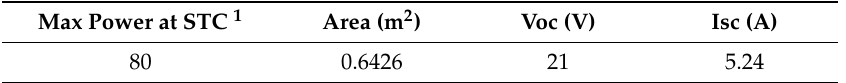
Figure 1. Block diagram of experimental photovoltaics (PV) system set-up: Roof-top sub-system (left) and lab sub-system (right). Table 1. Poly-crystalline silicon PV module characteristics (manufacturer: PTL Solar, UAE).